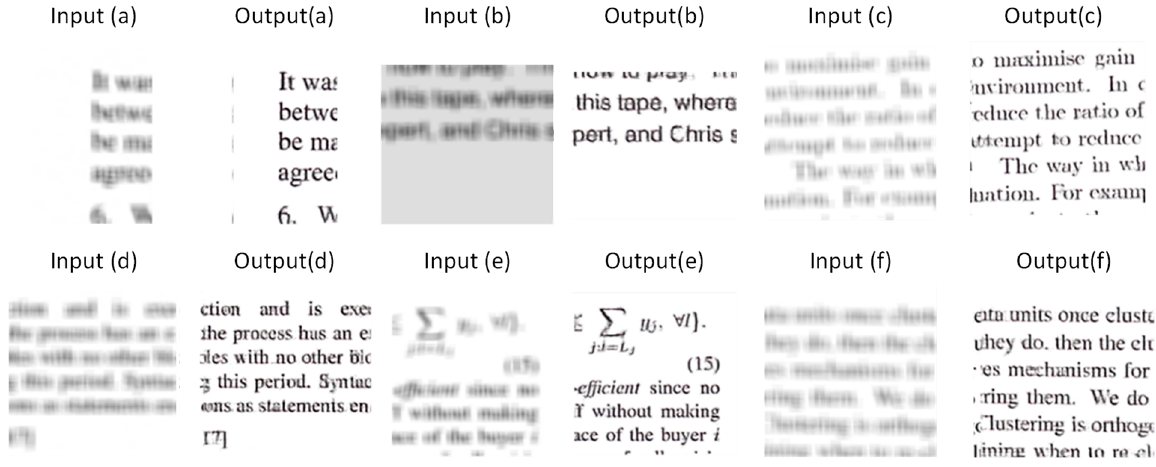
Figure 6. Sample results of deblurred images obtained by using our Module 1 model provided in Figure 4. Table 2. Showing the result of ablation study for the blur enhancement.